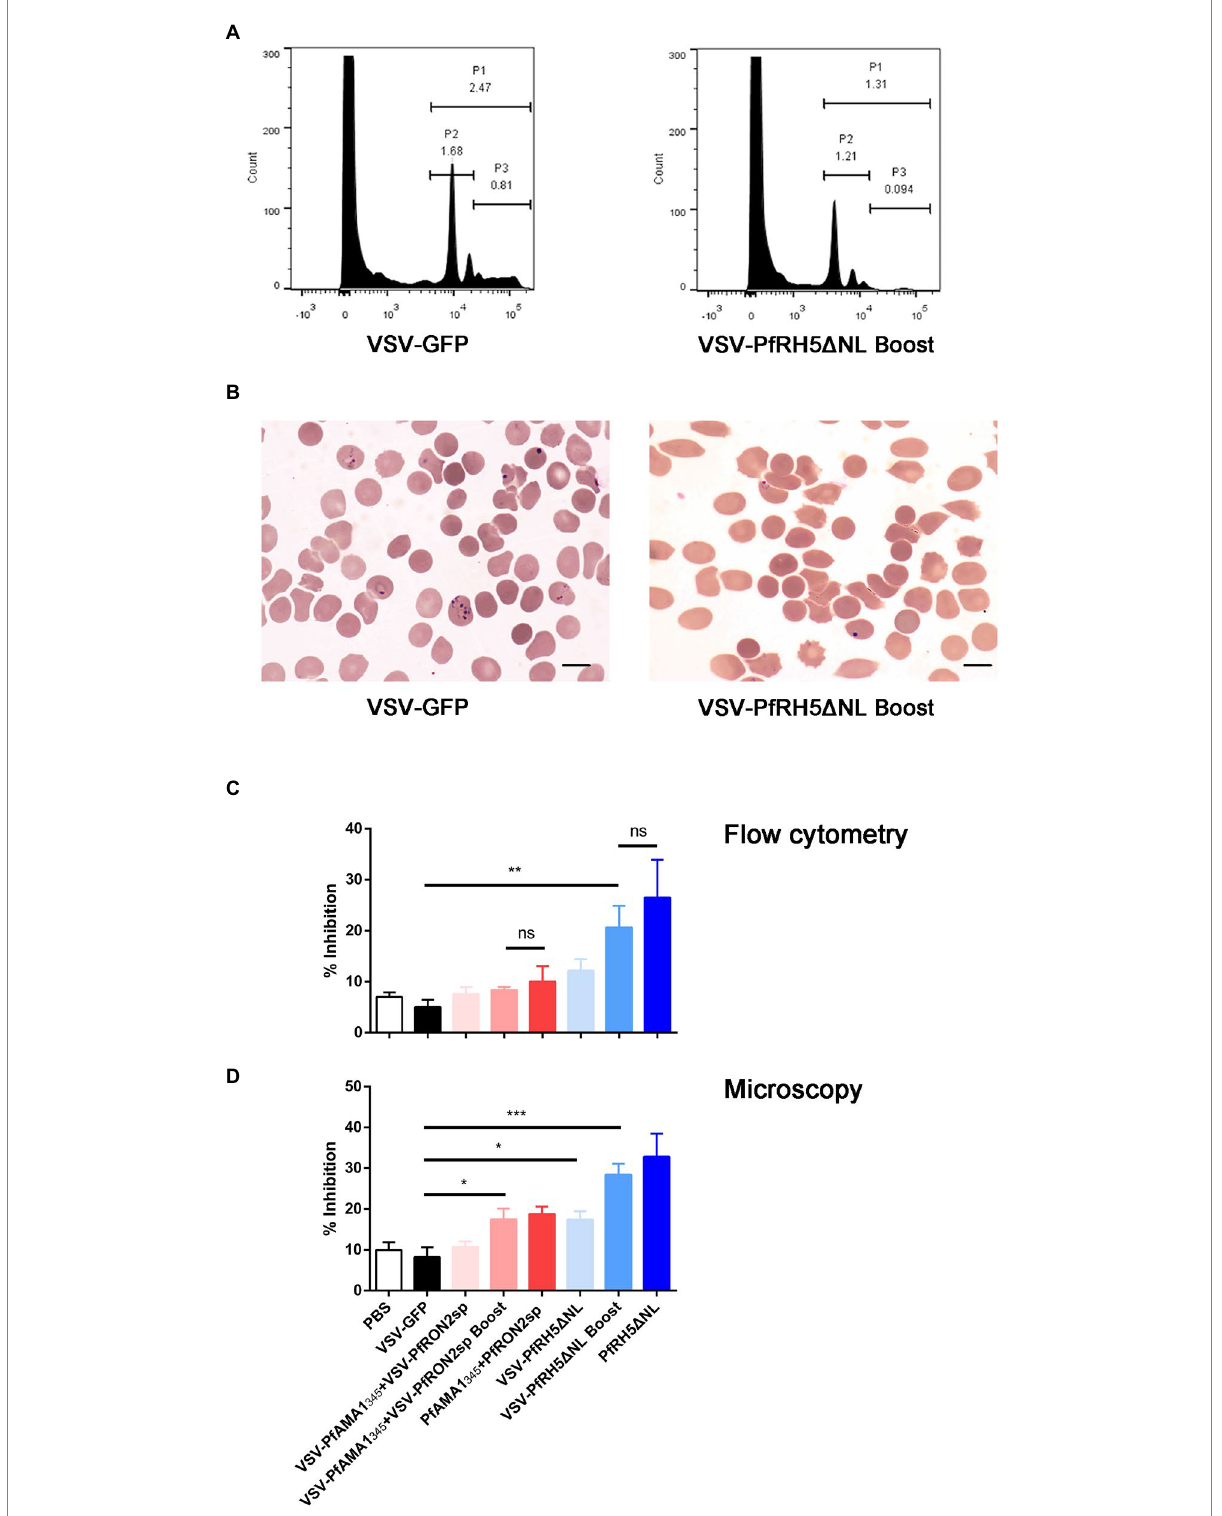
FIGURE 5 Inhibition efficiency of anti-PfAMA1 345 + PfRON2sp and anti-PfRH5 Δ NL antisera. (A) Parasitemia analysis were determined by flow cytometry using SYBR Green staining. P1 represents Plasmodium falciparum -infected erythrocytes, P2 represents ring forms after infecting erythrocytes with P. falciparum , P3 represents schizonts after infecting erythrocytes with P. falciparum . (B) Parasitemia analysis using microscopy. The bar represents 10 mm. (C) Inhibition of parasite invasion was determined using flow cytometry (C) and microscopy (D) . Error bars indicate SD. One-way AVONA was used to perform statistical analysis. Ns, no significant, * p < 0.05, ** p < 0.01, and *** p <